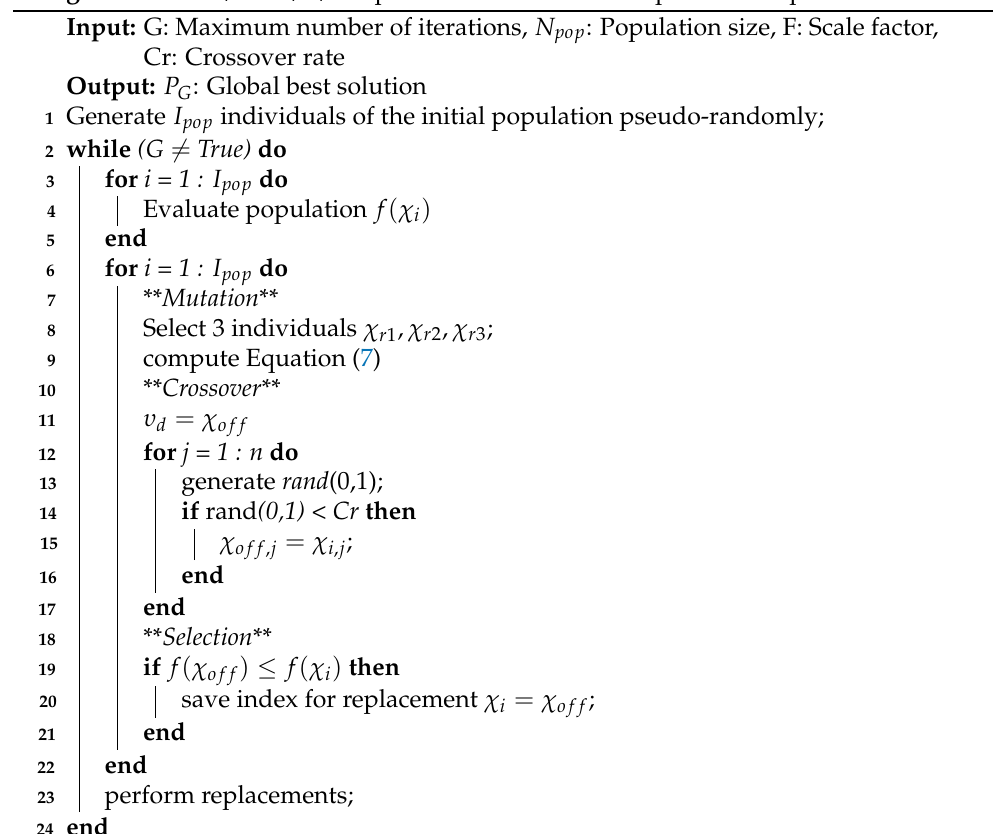
Algorithm 1: DE/rand/1/bin pseudocode used in the optimization